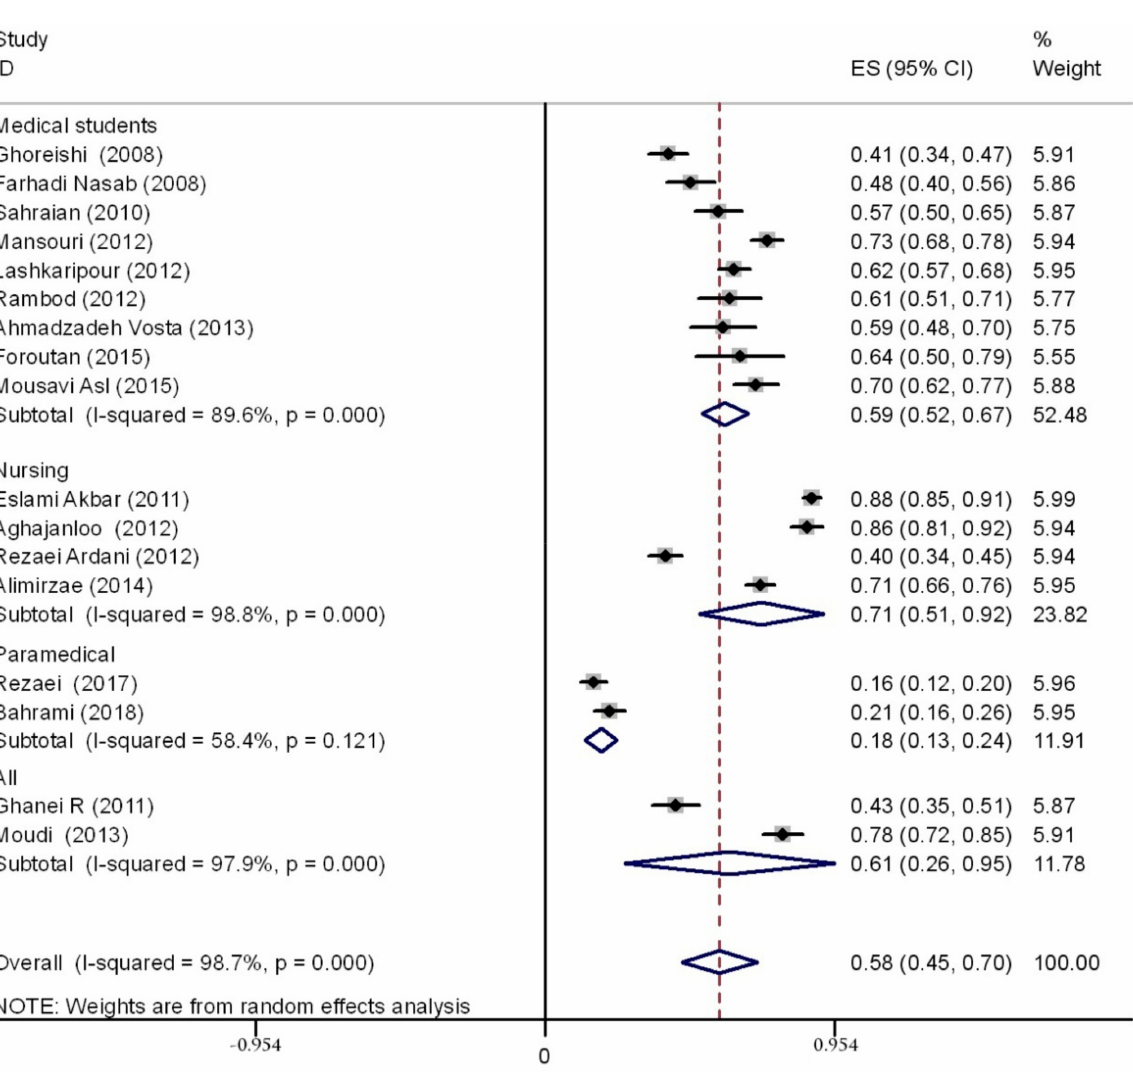
Figure 2. The forest plot showing the overall prevalence rate of sleep disturbances among Iranian medical and other allied health professions students and stratified by specific course degree. CI—confidence